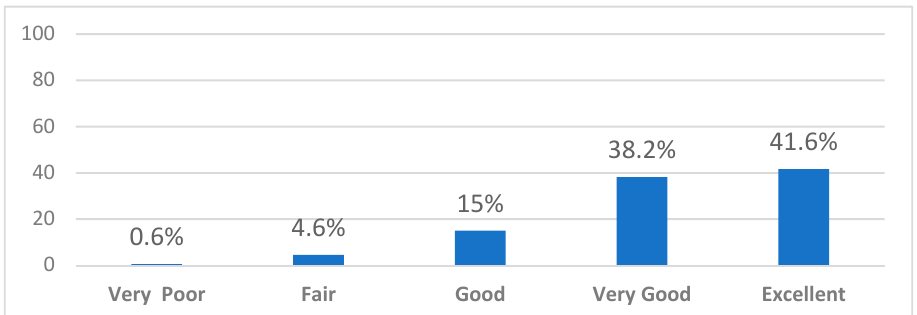
Figure 6. Faculty members overall rating of the virtual interview experience.